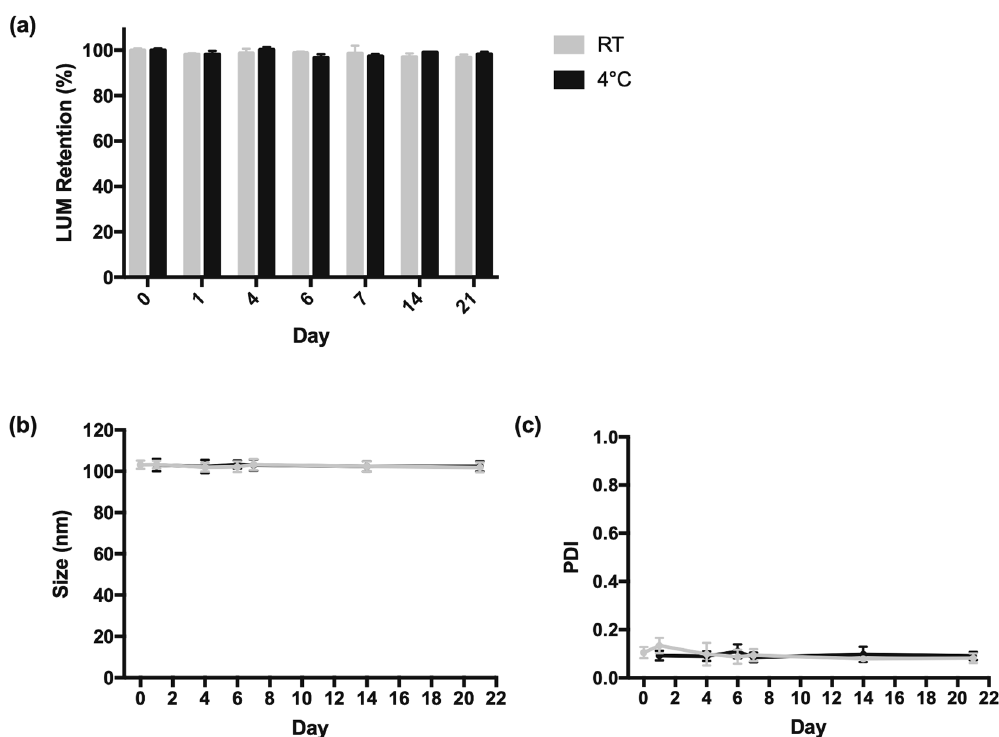
Figure 2. Long-term stability of thermoLUM stored at room temperature (RT, grey) or 4 °C (black) over 21 days. The liposome-encapsulated drug was separated from unencapsulated drug via size exclusion chromatography. The concentration of LUM was detected via HPLC analysis to determine the amount of drug retained in the liposomes at each timepoint ( a ). The size ( b ) and PDI ( c ) of thermoLUM were determined via DLS. The level of encapsulated drug, size, and PDI of liposomes were found to be stable over the 21-day